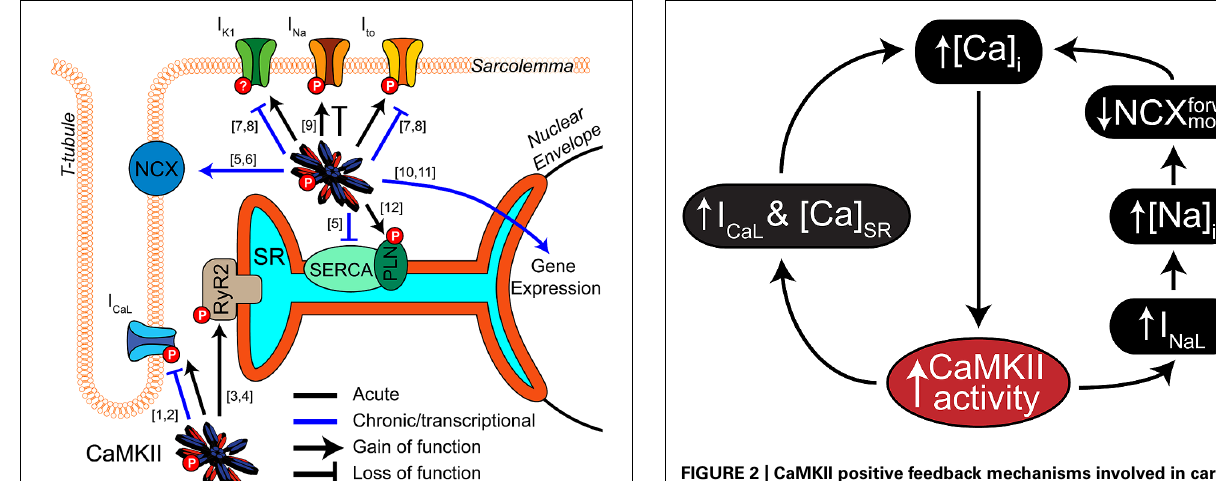
FIGURE 2 | CaMKII positive feedback mechanisms involved in cardiac disease. As a Ca 2 + regulated kinase, CaMKII is sensitive to any physiological mechanism that alters intracellular Ca 2 + cycling. Many of its own catalytic actions result in such alterations, and two gain-of-function effects that create positive feedback by enhancing Ca 2 + cycling occur at I CaL (left) and I Na (right). CaMKII regulation of I Na is thought to increase intracellular Na + via enhanced late I Na , which in turn reduces the thermodynamic potential for Ca 2 + extrusion via NCX. CaMKII regulation of I CaL more directly enhances Ca 2 + cycling by increasing Ca 2 + influx through slightly elevated peak current and slowed inactivation. 2012). Somewhat surprisingly, CaMKII activity and